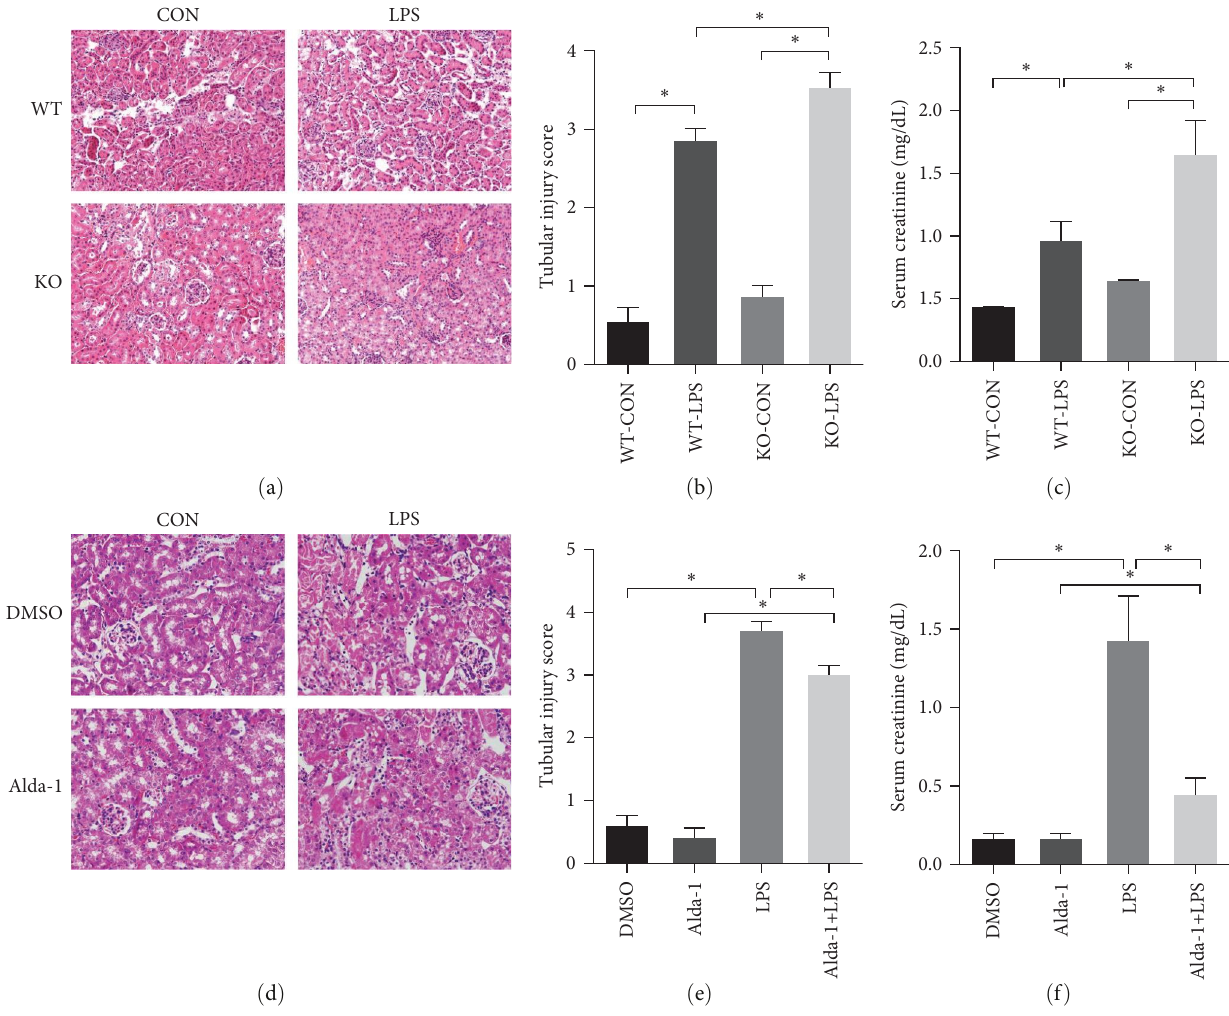
F IGURE 2: Effect of ALDH2-KO or ALDH2 activator Alda-1 pretreatment on the LPS-induced acute tubular injury and increase of serum creatinine (SCr). The characteristic of tubular injury included tubular epithelia swelling, loss of brush border, vacuolar degenerating, and tubular forming. The severity of tubular injury score was de fi ned from 0 to 4 according to the percentage of injured area: 0, normal tissue; 1, damaged area < 25 % ; 2, damaged area of 25 % – 50 % ; 3, damaged are of 50 % – 75 % ; 4, damaged area of 75 % – 100 % : (a) the collected kidneys of WT and KO mice were stained with hematoxylin and eosin (H & E); (b) quantitative evaluation of morphological tubular damage in WT and KO mice; (c) quanti fi cation of SCr in WT and KO mice; (d) the collected kidneys of mice with or without pretreatment of Alda-1 were stained with H & E; (e) quantitative evaluation of morphological tubular damage in mice with or without Alda-1 pretreatment; (f) quanti fi cation of SCr in mice with or without Alda-1 pretreatment. Scale bars: 50 μ m. All data are expressed as mean Æ SEM ( n = 6). ∗ P < 0 :